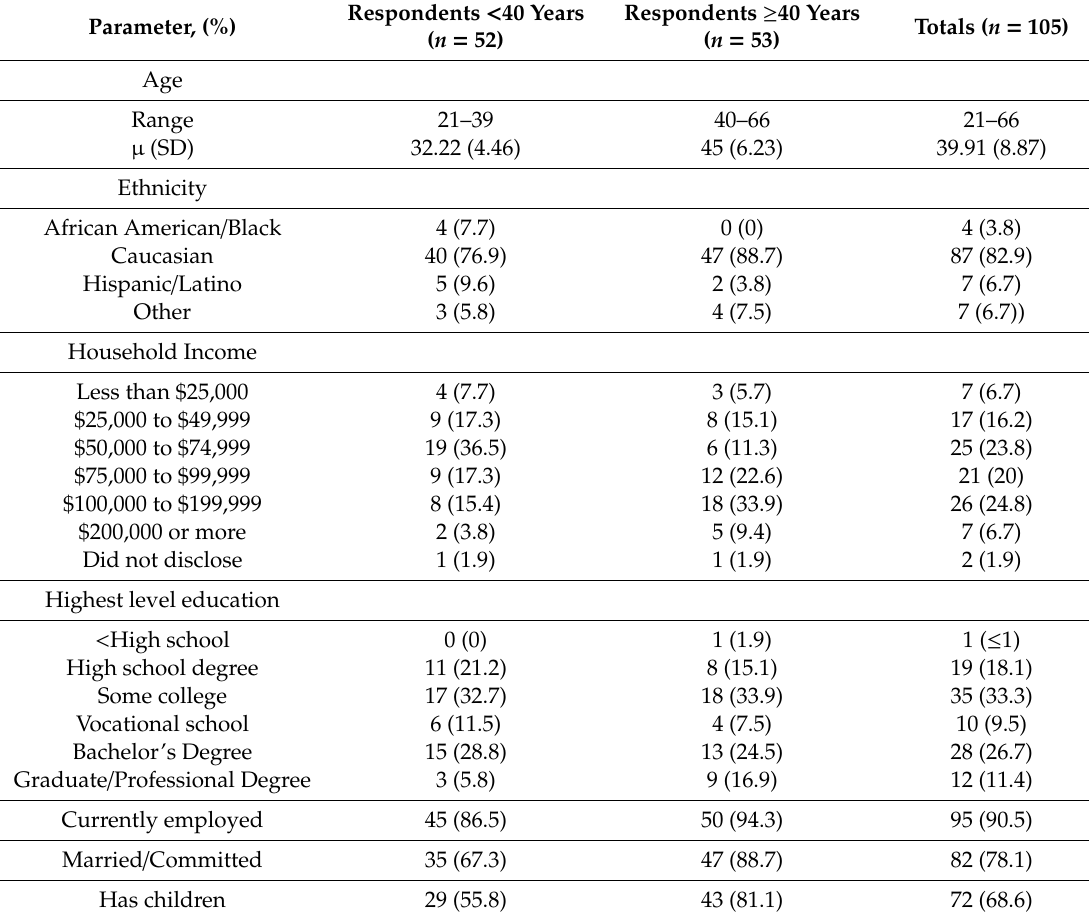
Table 2. Demographic data of PT survey